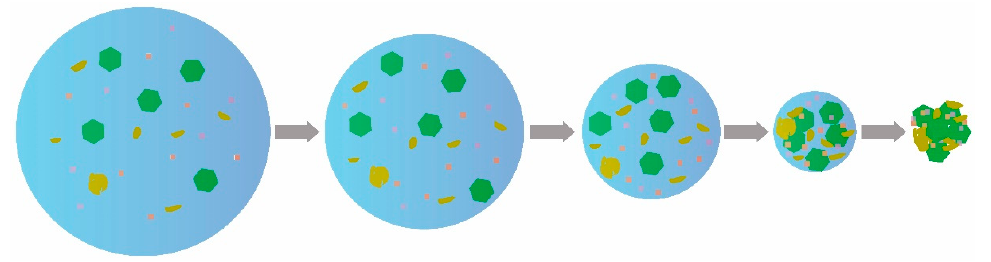
Figure 4. Droplet evaporation process (taken from Verreault, 2008 [13]).